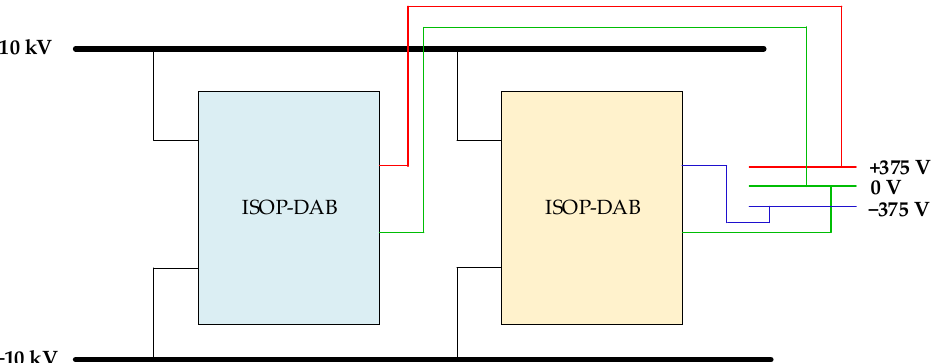
Figure 12. Submodule structure of DCT for the charging pile accesses scenario.